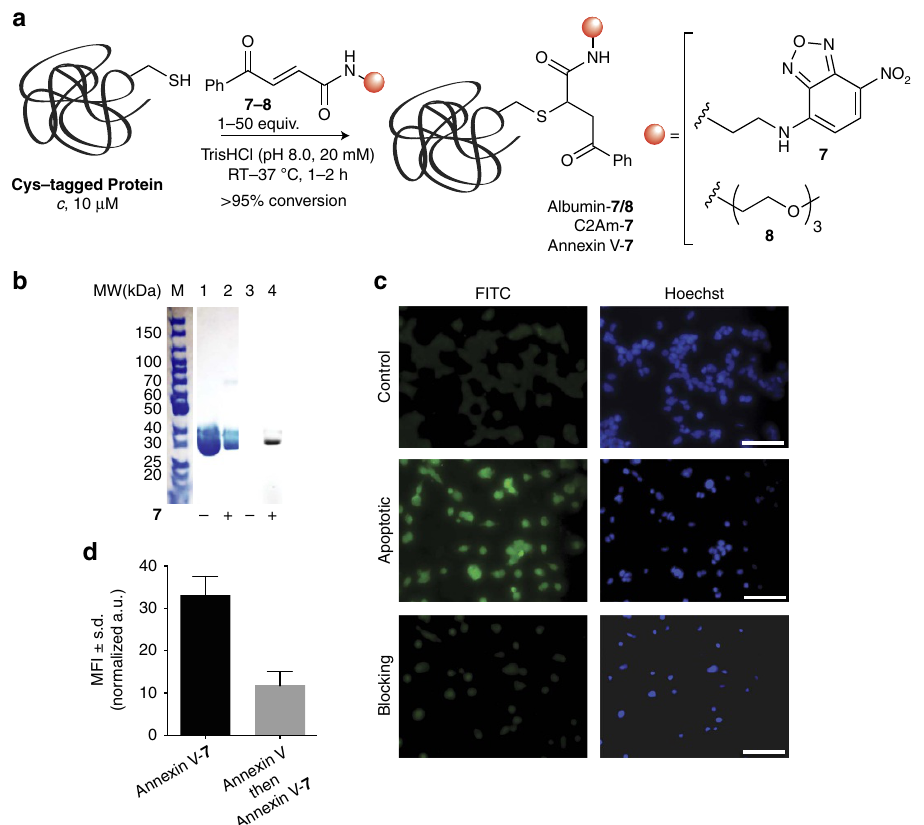
Figure 3 | Fluorescent labelling and PEGylation of proteins. ( a ) Scheme of the modification of albumin and Annexin V with fluorescent 7 or PEG 8 functionalized carbonylacrylic reagents. See Supplementary Methods for full synthetic details. ( b ) Treatment of Annexin V with 7 afforded a fluorescent protein conjugate, as detected by SDS–polyacrylamide gel electrophoresis gel. Lanes 1 and 2, coommassie staining. Lanes 3 and 4, fluorescence. ( c ) Fluorescence images of non-apoptotic (control) and apoptotic HEK293 cells after labelling with Annexin V- 7 . Blocking studies were performed